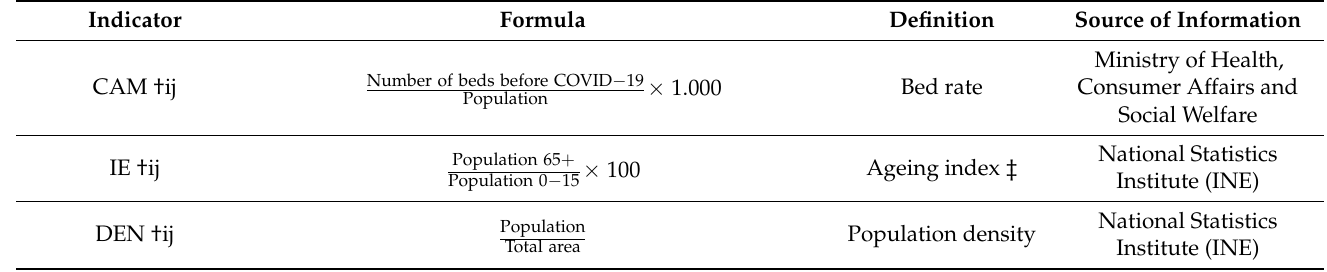
Table 1. Health system structure, epidemiological and socioeconomic